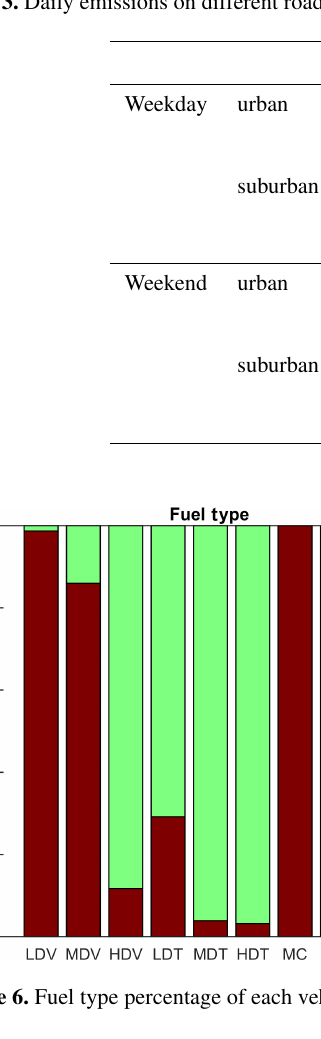
Table 3. Daily emissions on different road types in urban and suburban areas (unit: Mgd − 1 ).